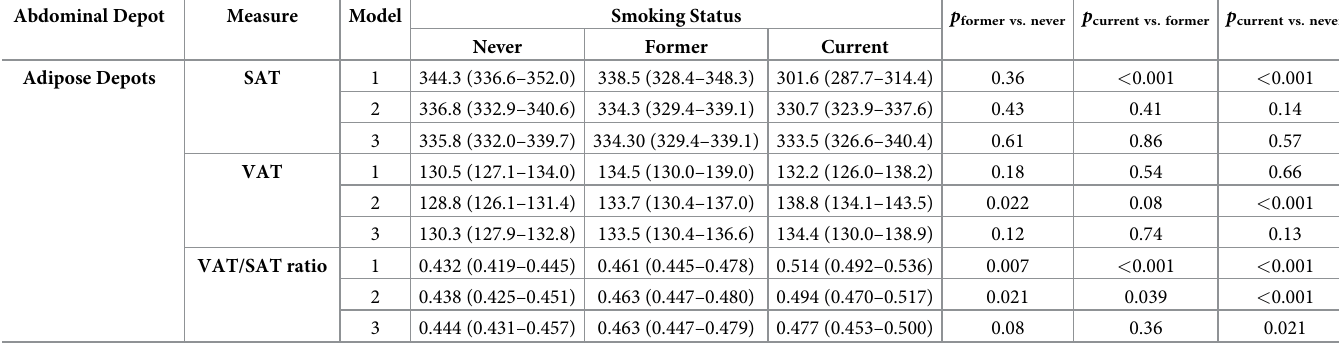
Table 3. Multivariable models of Y25 CT abdominal adipose tissues and muscle composition (least squares mean [95% CI]) by Y25 smoking status � . Abdominal Depot Measure